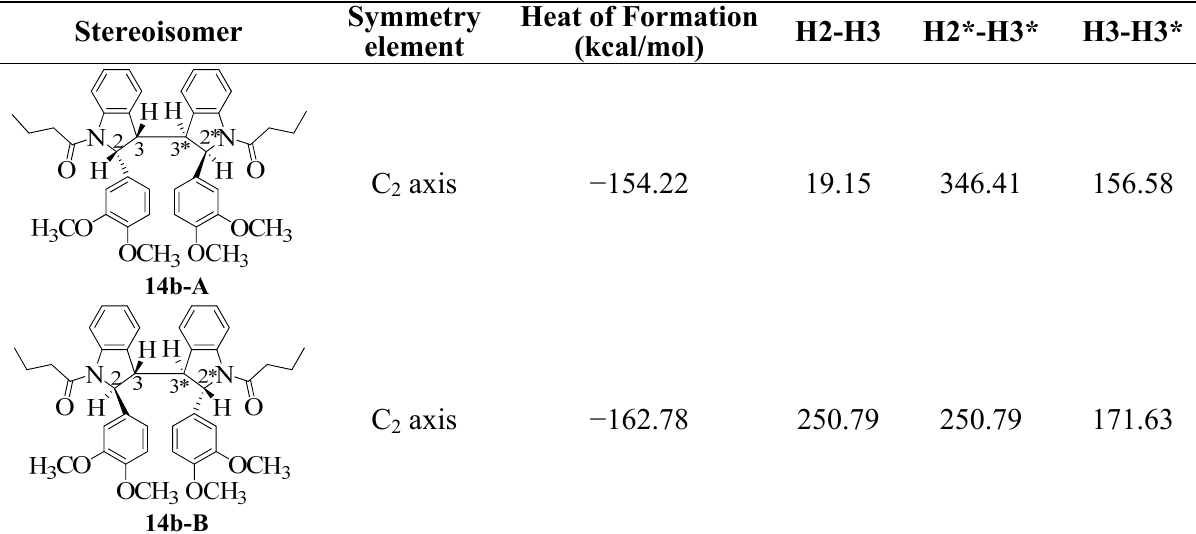
Table 3. PM6 calculation for 14b